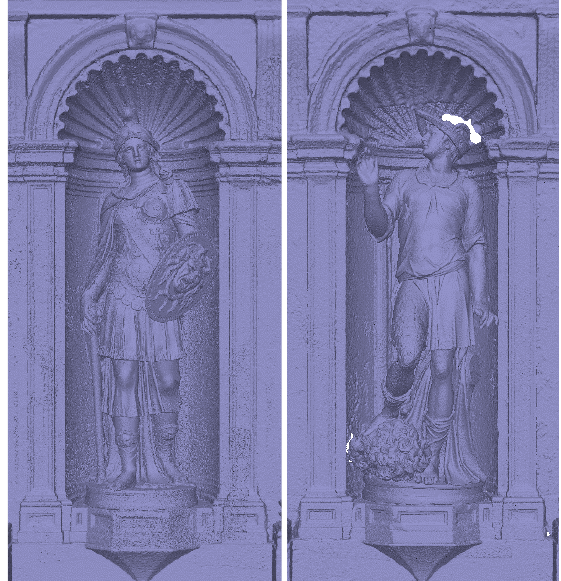
Figure 18. Mesh of the models of Pallas and Mercury.